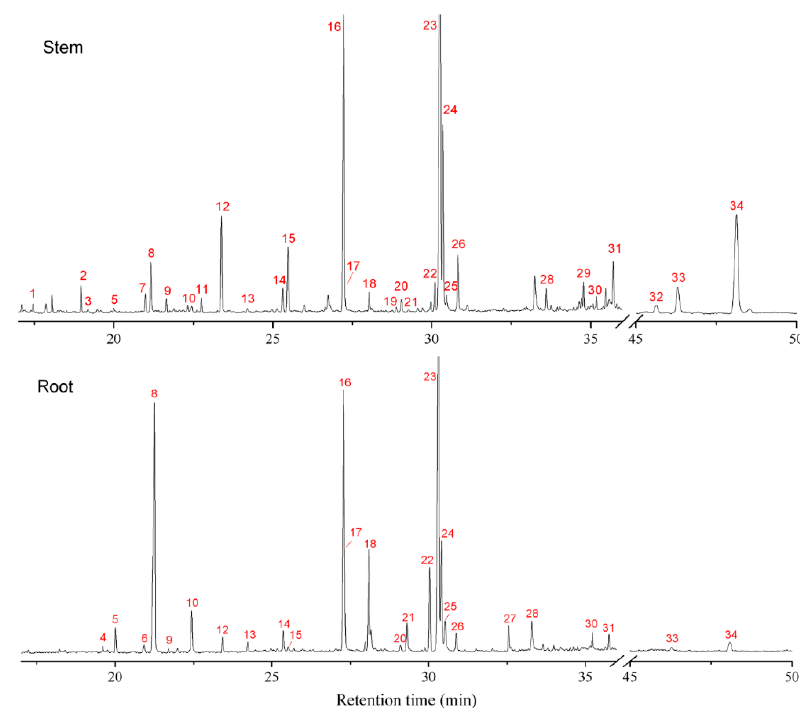
Figure 2. Typical GC chromatograms of TMS-derivatized oily extracts from AS stem and root. The identified compounds were numbered according to retention time. Peak labels are the same as the numbers in Figure 3 and Table 1.